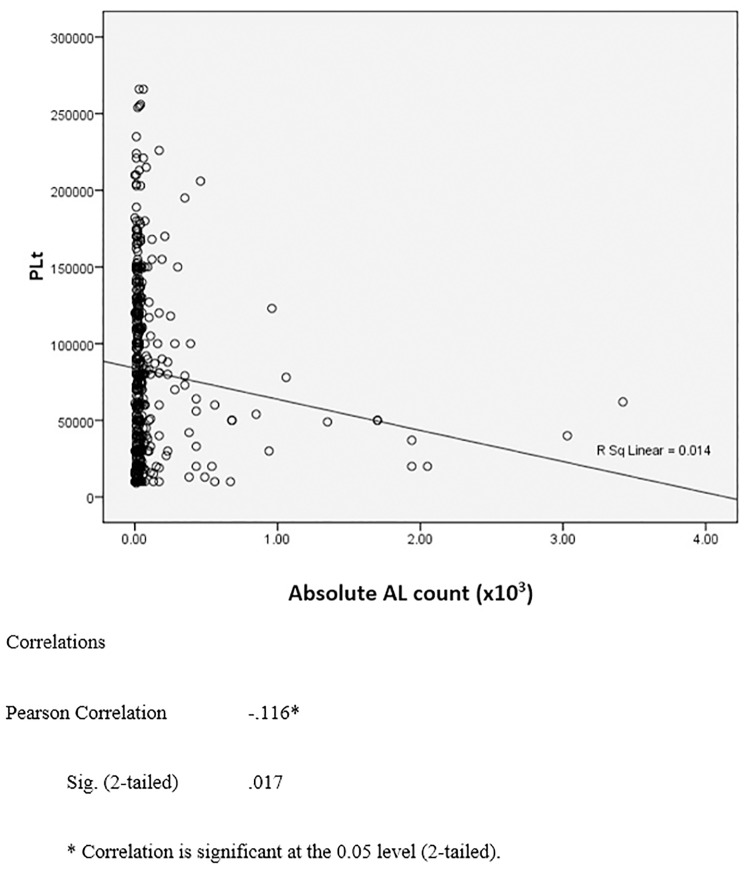
The correlation between platelet count and absolut atypical lymphocyte count (×103).